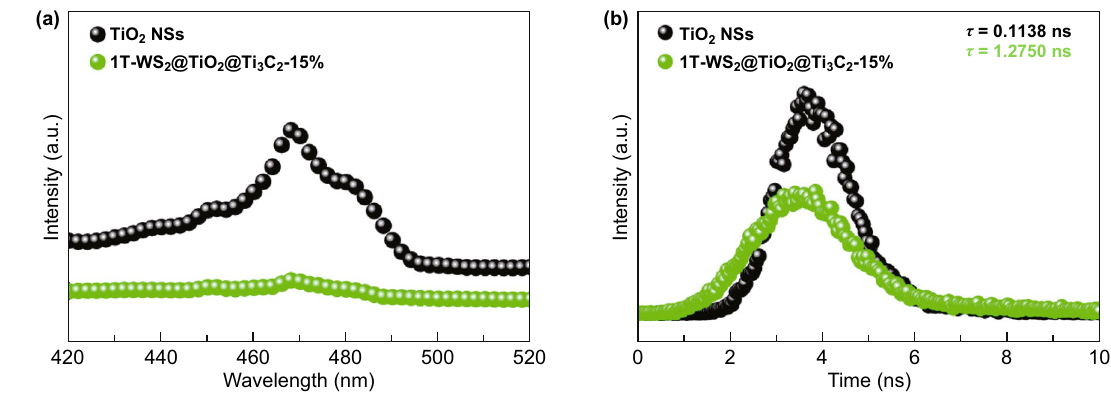
Fig. 7 a Steady and b time-resolved PL spectra of TiO 2 NSs and 1T-WS 2 @TiO 2 @Ti 3 C 2 composites (15 wt% WS 2 ), λ ex = 325